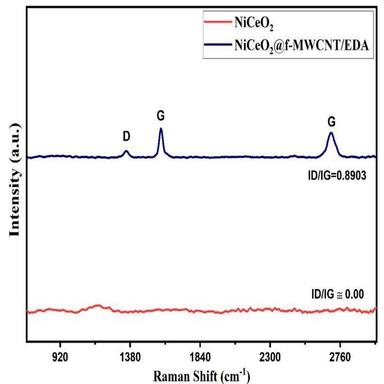
Raman analyses of NiCeO2, NiCeO2@f-MWCNT/EDA.